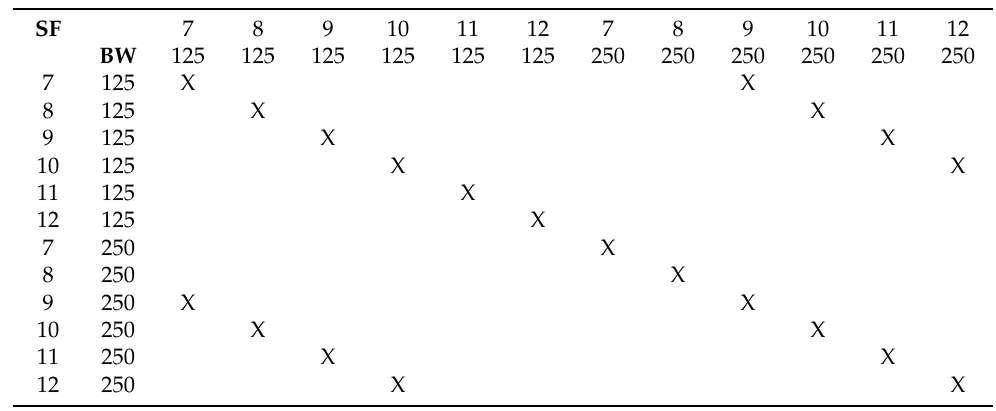
Table 1. Orthogonal combinations of SF and